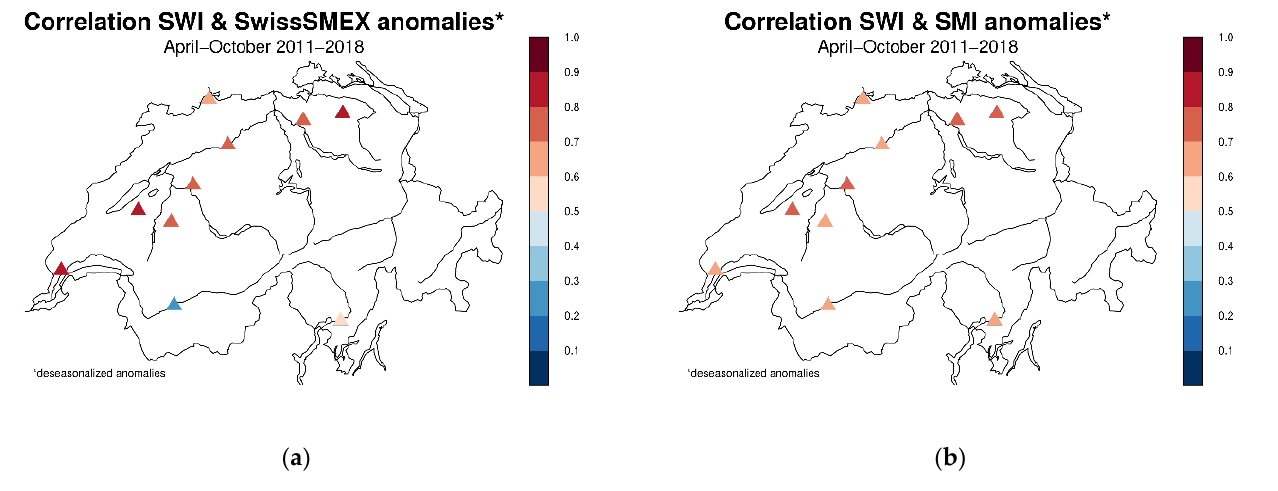
Figure 5. Correlations of ( a ) the ASCAT soil water index (SWI) and the SwissSMEX soil moisture measurements and ( b ) the SWI and the soil moisture index (SMI) at the ten considered grassland sites during April to October from 2011 to 2018 based on deseasonalized anomalies.